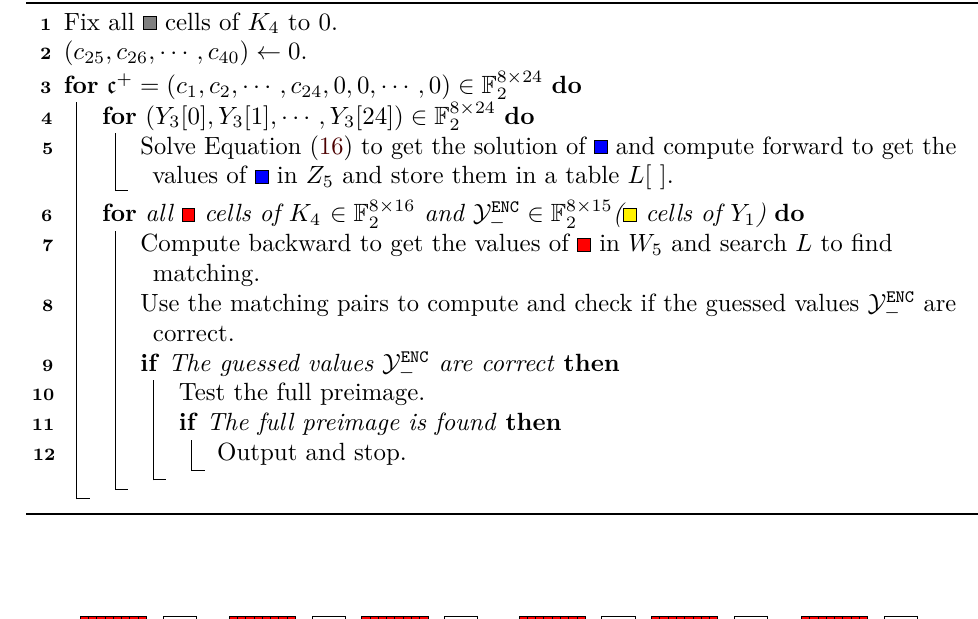
Algorithm 10: The MITM preimage attack on 7.5-round Streebog-512 com- pression function